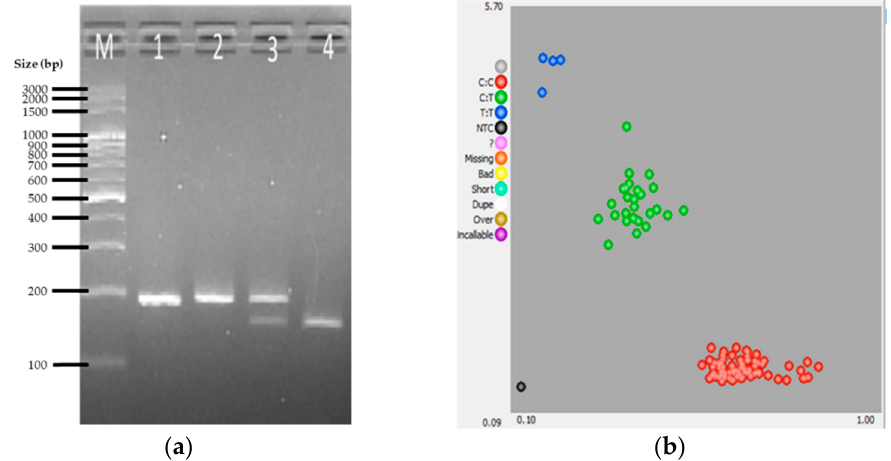
( b ) Figure 2. Representative results for MTCYB gene SNP genotyping by PCR-RFLP and KASP assays. ( a ) Agarose gel electrophoretic profile of selected samples showing the banding patterns for the MTCYB G allele (lane 1), and MTCYB C allele (lane 2), and the undigested PCR amplicon (lane 3). ( b )